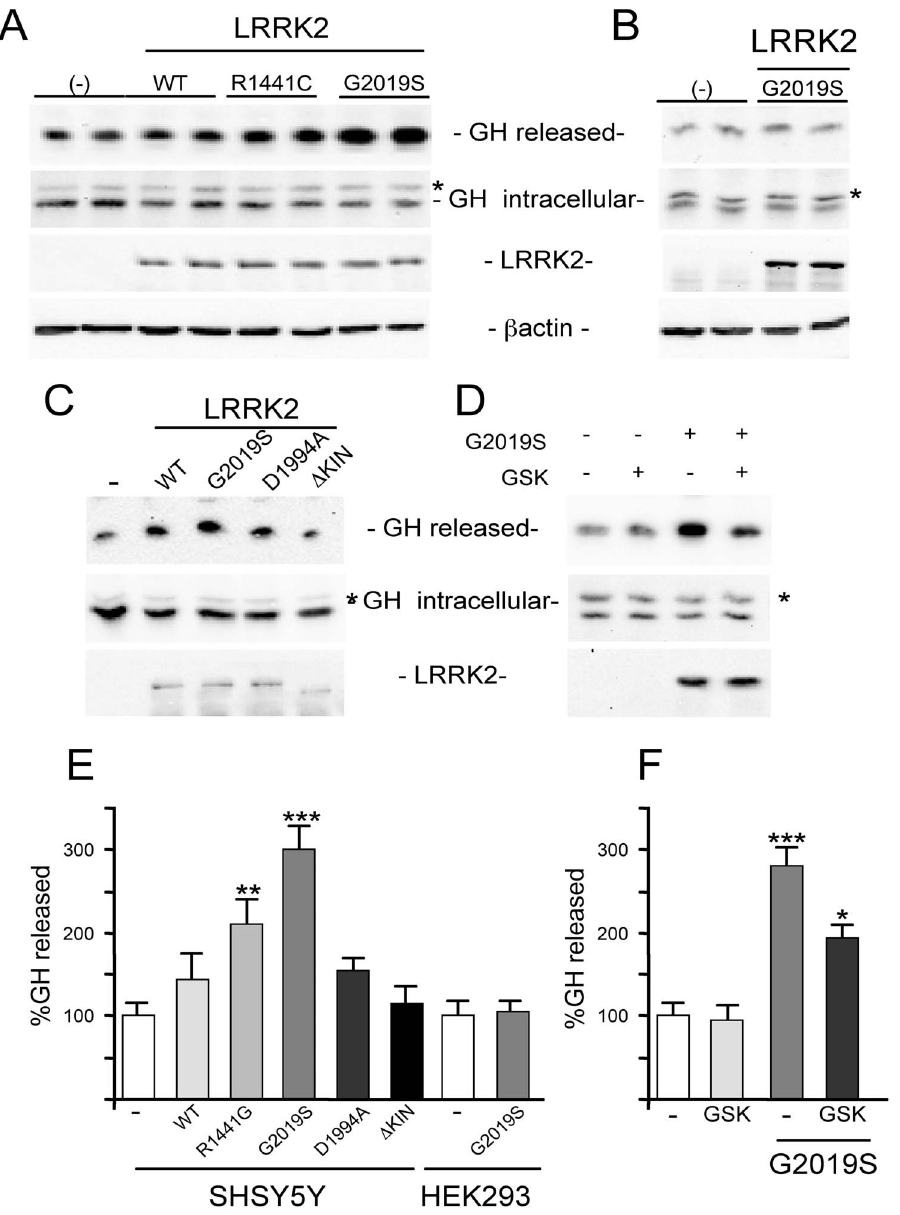
Figure 6. Effect of LRRK2 expression on released GH from neuronal and non-neuronal cells. (A) SH-SY5Y were transfected with plasmids coding for GH alone ( 2 ) or with the indicated mutant LRRK2s. Western blot on the extracellular medium (released GH) or cell protein extracts were performed using anti-myc antibodies for GH or LRRK2 and anti- b -actin as controls for equal loading of samples. The asterisk (*) indicates a non- specific band. (B) HEK293 cells were transfected with GH alone ( 2 ) or with LRRK2 G2019S . Western blot on the extracellular medium (released GH) or cell protein extracts were performed using Anti-myc antibody for GH or LRRK2 and anti- b -actin as controls for equal loading of samples. The asterisk (*) indicates a non-specific band. (C) Analysis of LRRK2 D1994A or LRRK2 D kinase on GH extracellular level in the same experimental conditions. (D) Effect of LRRK2 inhibitor on GH extracellular level in the same experimental conditions (E) Quantification by Student’s t test of data obtained in (A–B–C). **p , 0,01 and ***p , 0,001 versus ( 2 ). (F) Quantification by Student’s t test of data obtained in (D). *p , 0,05 and ***p , 0,001 versus ( 2 ).